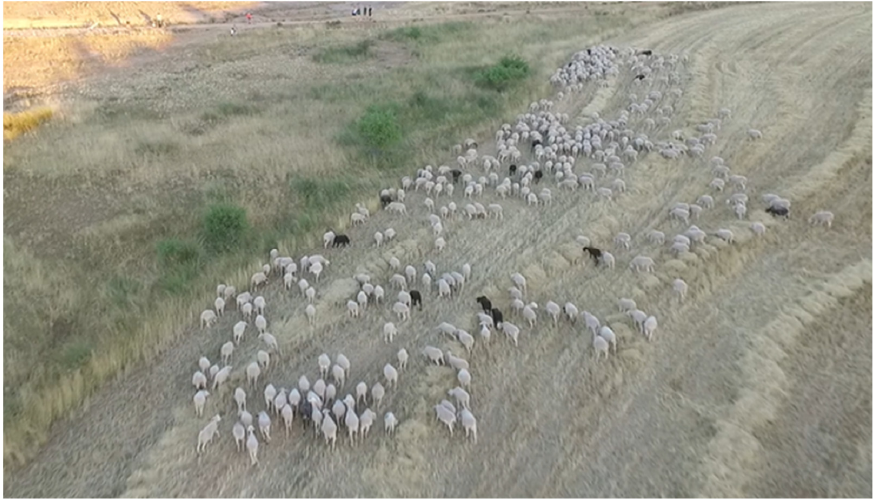
Figure 12. Cattle monitoring via UAV.